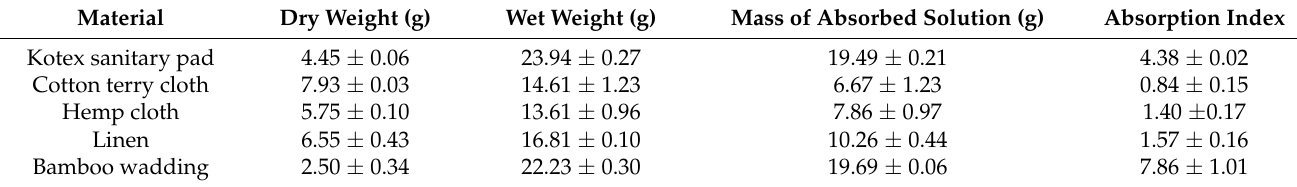
Table 1. Absorption index of the materials investigated in the present